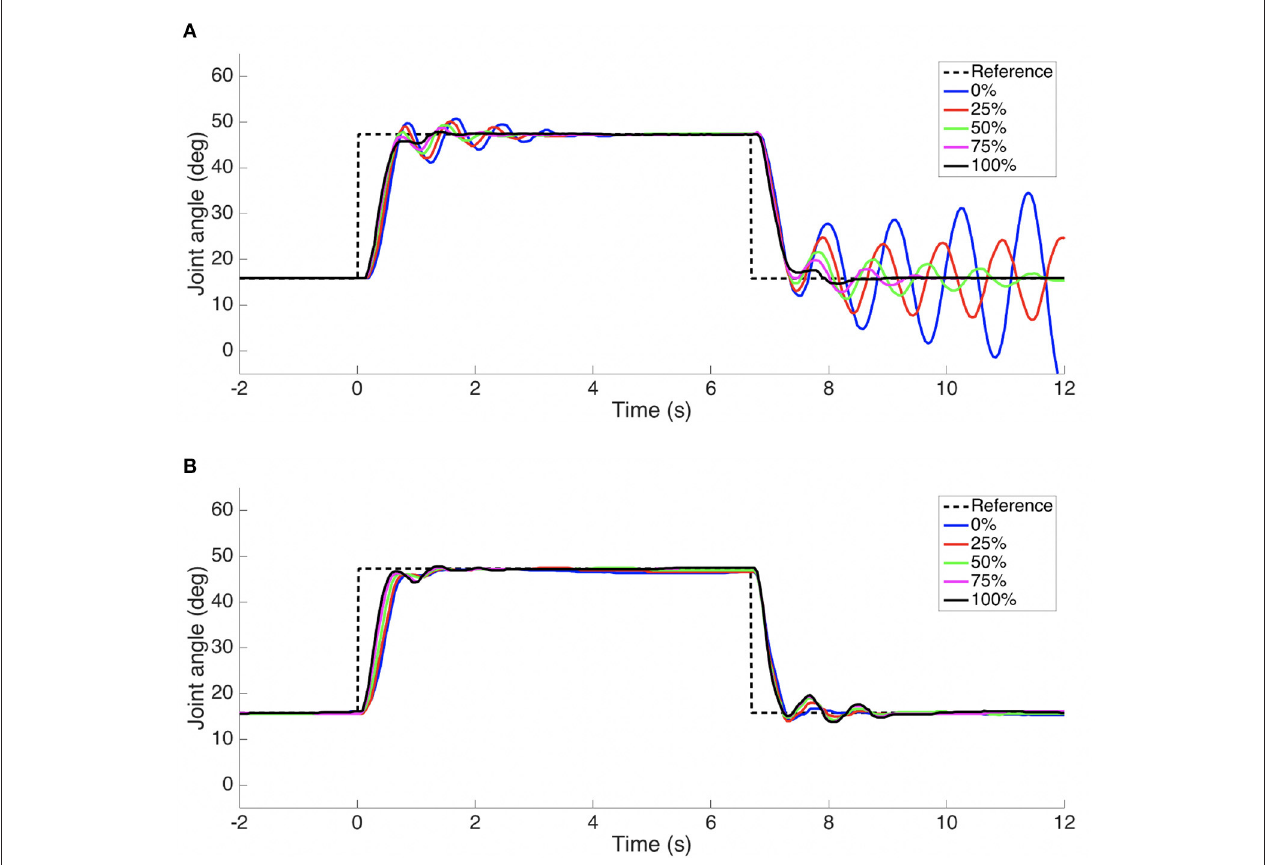
FIGURE 10 | A combination of a ballistic phase and a slower feedback phase performs well even with PD gains that are not “tuned” for the situation. Step responses of the shoulder pitch joint with elbow extended and hand carrying a 275 g payload. The PD gains were tuned for the situation where the elbow was half-extended and the hand empty. Average of 3 attempts for each trajectory. An angle of 0 corresponds to a vertically hanging arm. (A) Feedback control only (B) Two-phase ballistic/feedback control. The percentage in the legend indicates the co-contraction level the arm had at the onset of the movement. See Figure 11A for the co-contraction profiles followed for the two-phase ballistic/feedback